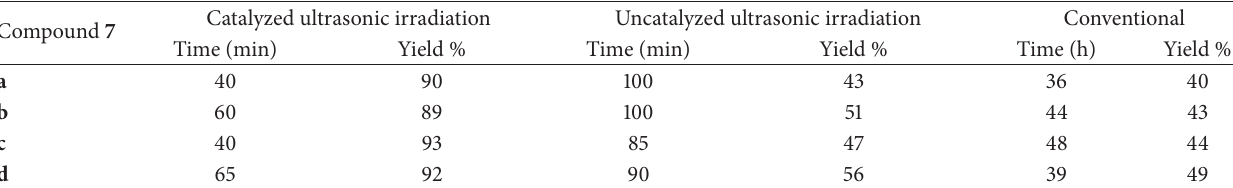
Table 2: Synthesis of 4-oxothiazolidine derivatives ( 7a – d ) under catalyzed ultrasonic irradiation, uncatalyzed ultrasonic irradiation, and using the conventional method.